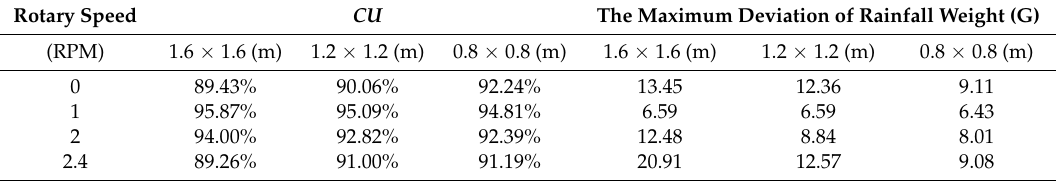
Table 2. Summary of the test results indicating the influence of rotary speed and the test area on CU and the maximum deviation of rainfall weight. The maximum deviation of rainfall weight refers to the difference between the maximum rainfall weight and the minimum rainfall weight of all 81 measuring